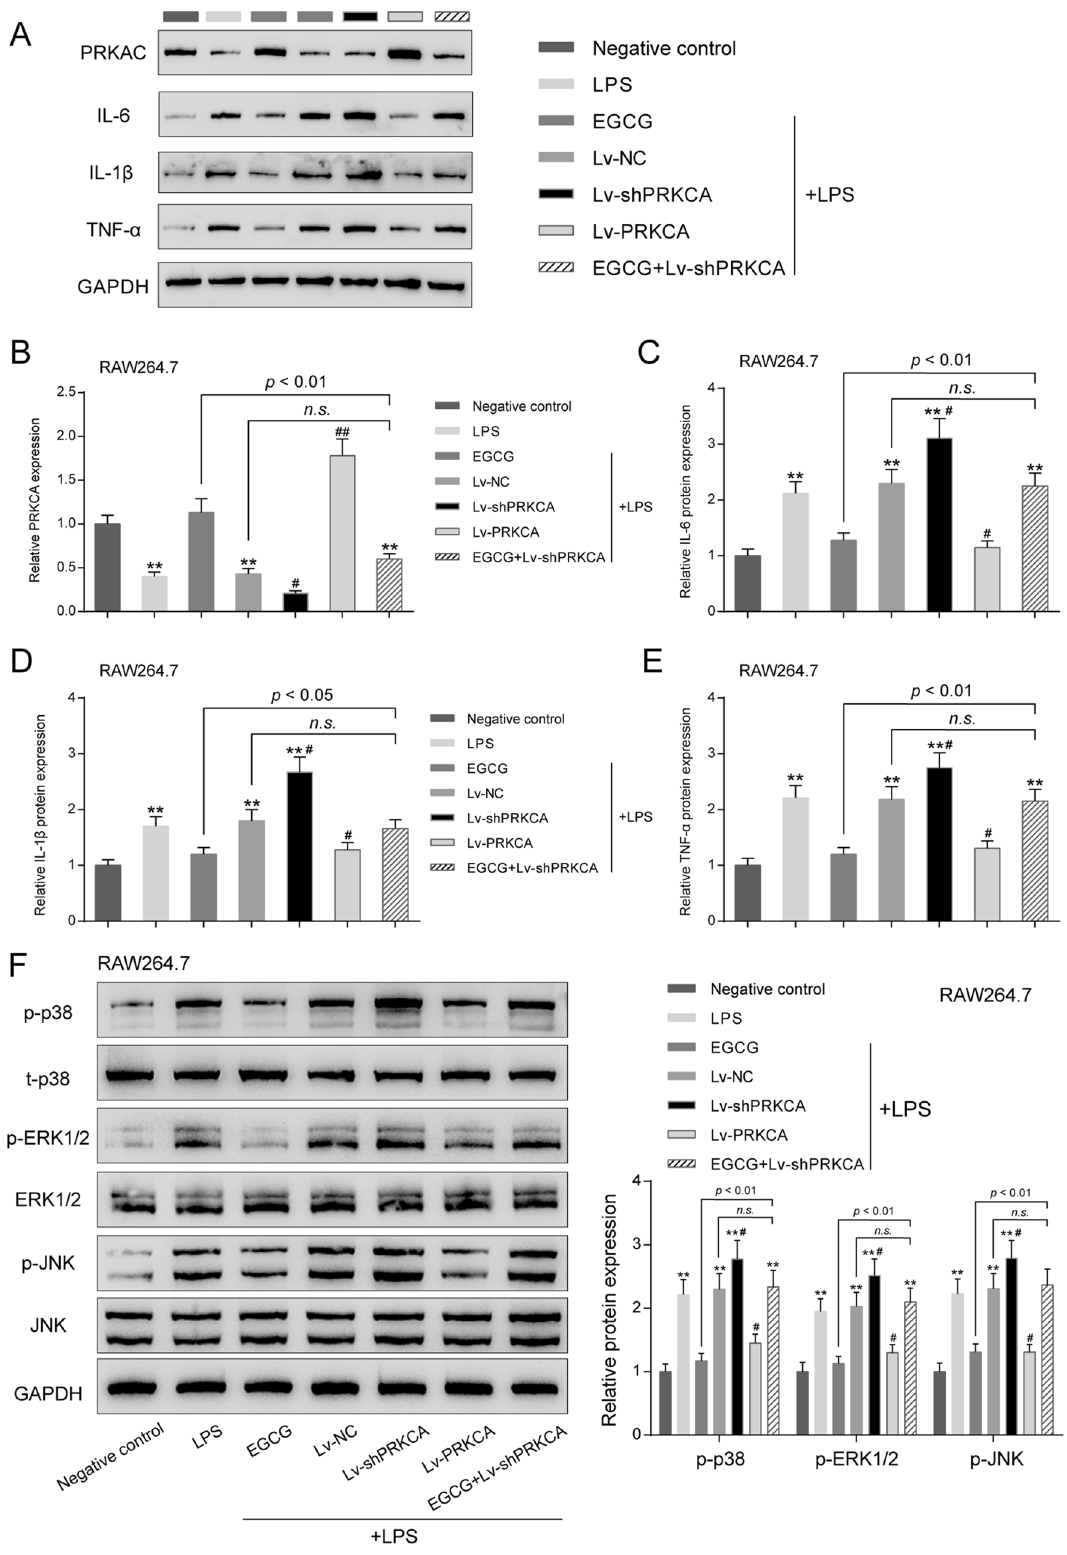
Figure 6. Effects of PRKCA on LPS-induced inflammatory responses through MAPK pathway in vitro. Mouse macrophage RAW 264.7 cells were divided into seven groups: the negative control group, the LPS group, the LPS + EGCG group, the LPS + Lv-NC group, the LPS + Lv-shPRKCA group, the LPS + Lv-PRKCA group, and the LPS + EGCG + Lv-shPRKCA group. Cells in each group were treated and/or infected accordingly. ( A – E ) The protein levels of PRKCA, IL-6, IL-1β, and TNF-α were determined using Immunoblotting. ( F ) The protein expression levels of MAPK signaling pathway-related proteins, including p-p38, p38, p-ERK1/2, ERK1/2, p-JNK and JNK in each group were detected using Immunoblotting. ** P < 0.01 compared to the control group; # P < 0.05, ## P < 0.01 compared to the LPS + Lv-NC